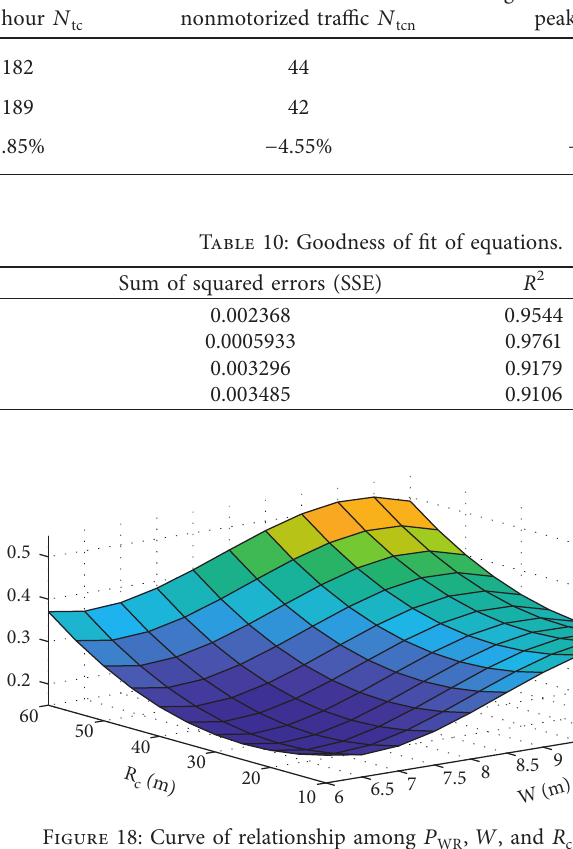
, W , and R for driveway WR c